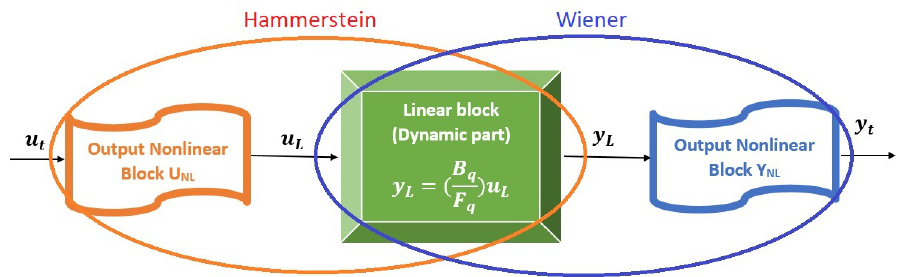
Figure 8. Reduced model